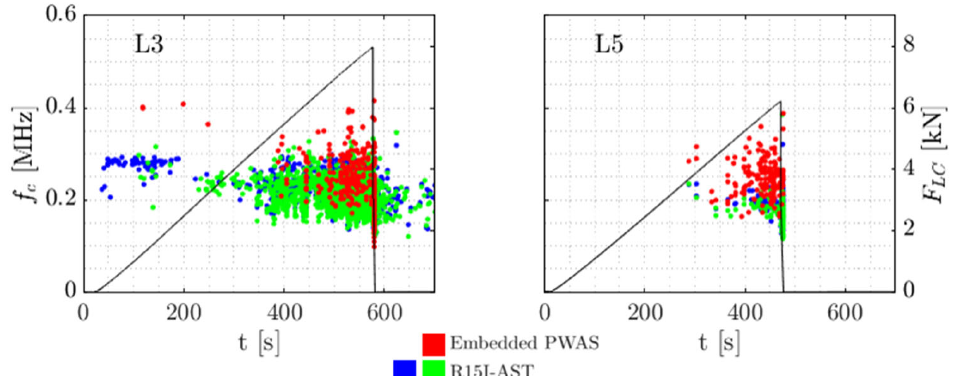
Figure 7. Centroid frequency f c of all measured signals over time and load cell force F LC for the large ‘L’ embedded sensors and the two R15I-ASTs. Note L3 has been subject to noise removal as is explained in Section 3.1.3. The final outcome is shown here.